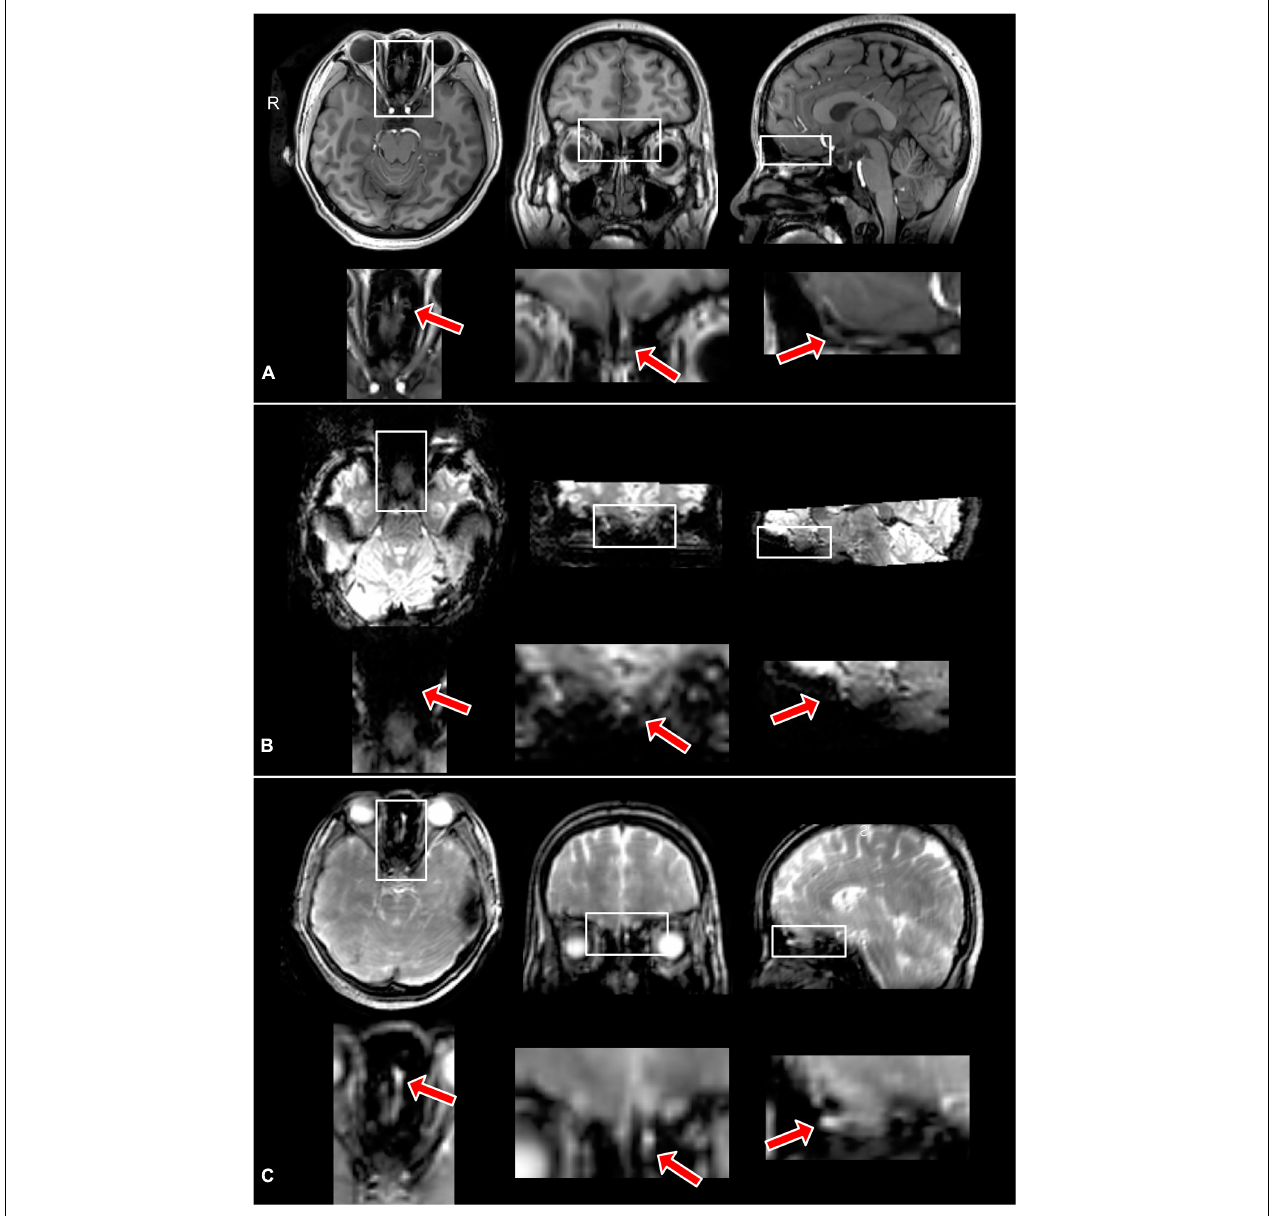
FIGURE 3 | Typical MPRAGE (A) , GRE EPI BOLD (B) , and T2prep BOLD (C) images from one subject. As the size of the olfactory bulb is small, the regions in the white boxes covering the areas around the olfactory bulb are magnified in the panel below each image for better visualization. The red arrows indicate the location of the olfactory bulb. The olfactory bulb can be clearly identified in the MPRAGE and T2prep images, but not in the GRE EPI images due to substantial susceptibility artifacts. All images are from the same location. Note that the eye ball region in the GRE EPI (B) images also showed high distortion and dropout [the outline of